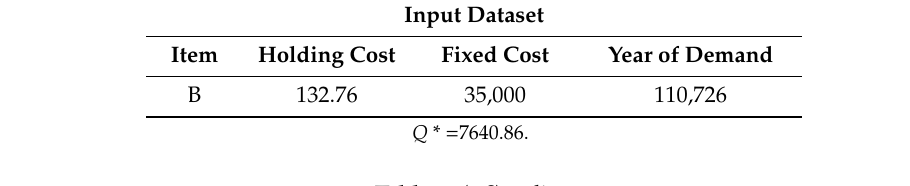
Table 5. ( s , S ) policy.